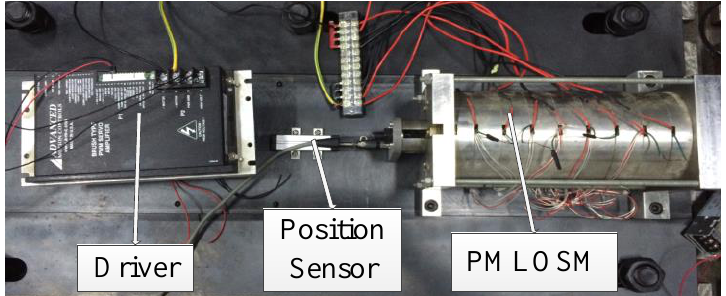
Figure 19. PMLOSM